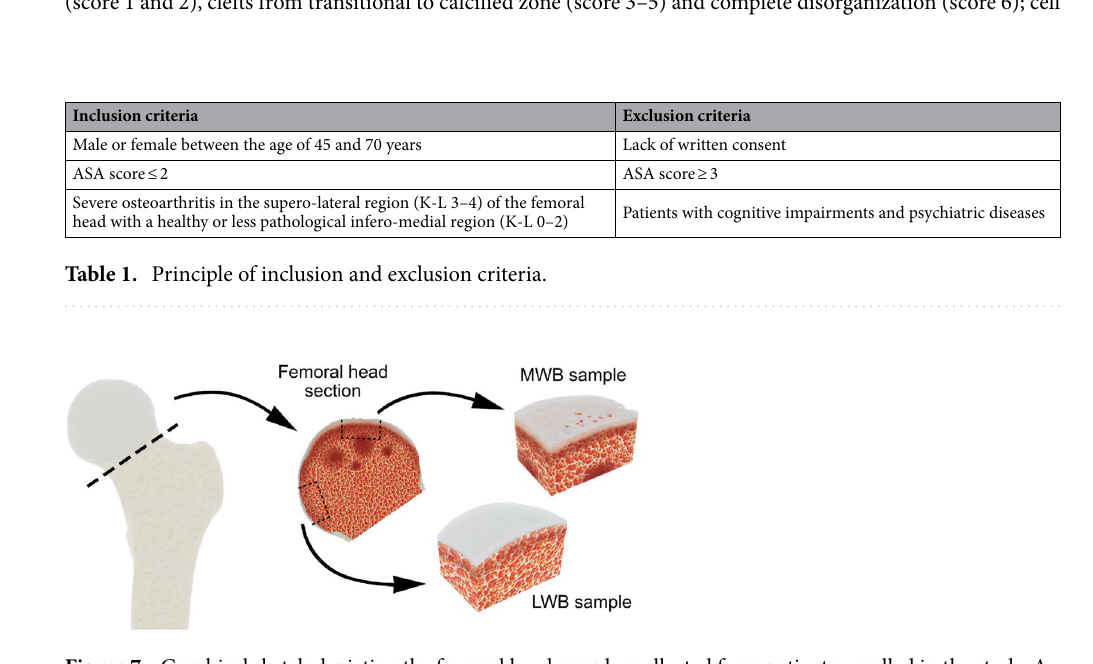
Figure 7. Graphical sketch depicting the femoral head samples collected from patients enrolled in the study. A femoral head was excised from each patient who underwent unilateral total hip arthroplasty. A most weight- bearing sample (MWB) was procured from the supero-lateral region. A least weight-bearing sample (LWB) was procured from the infero-medial